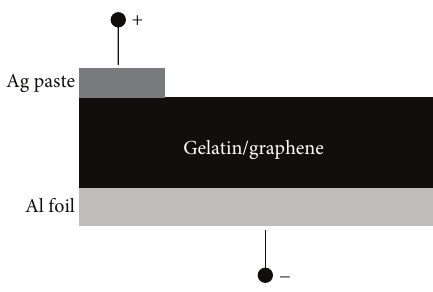
Figure 1: Cross section geometry of the device.